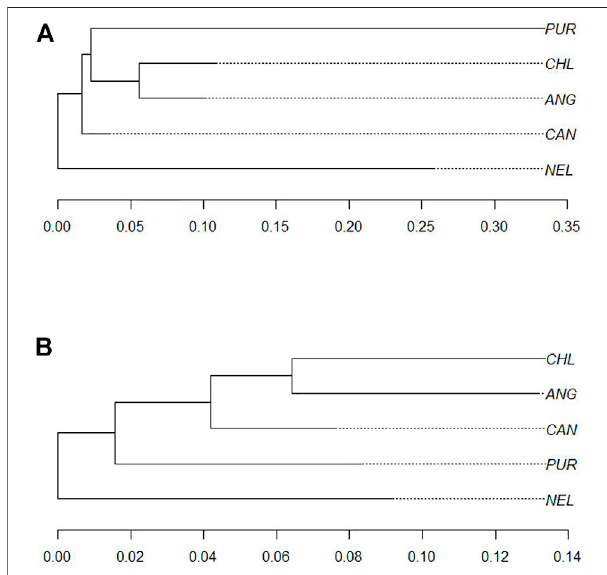
FIGURE 5 | Phylogenetic trees. (A) Phylogenetic tree for homozygous regions comparing the Purunã (PUR), Angus (ANG), Canchim (CAN), Charolais (CHL), and Nellore (NEL) populations. (B) Phylogenetic tree for growth pathway in heterozygous-enriched regions comparing the Purunã (PUR), Angus (ANG), Canchim (CAN), Charolais (CHL), and Nellore (NEL) populations.